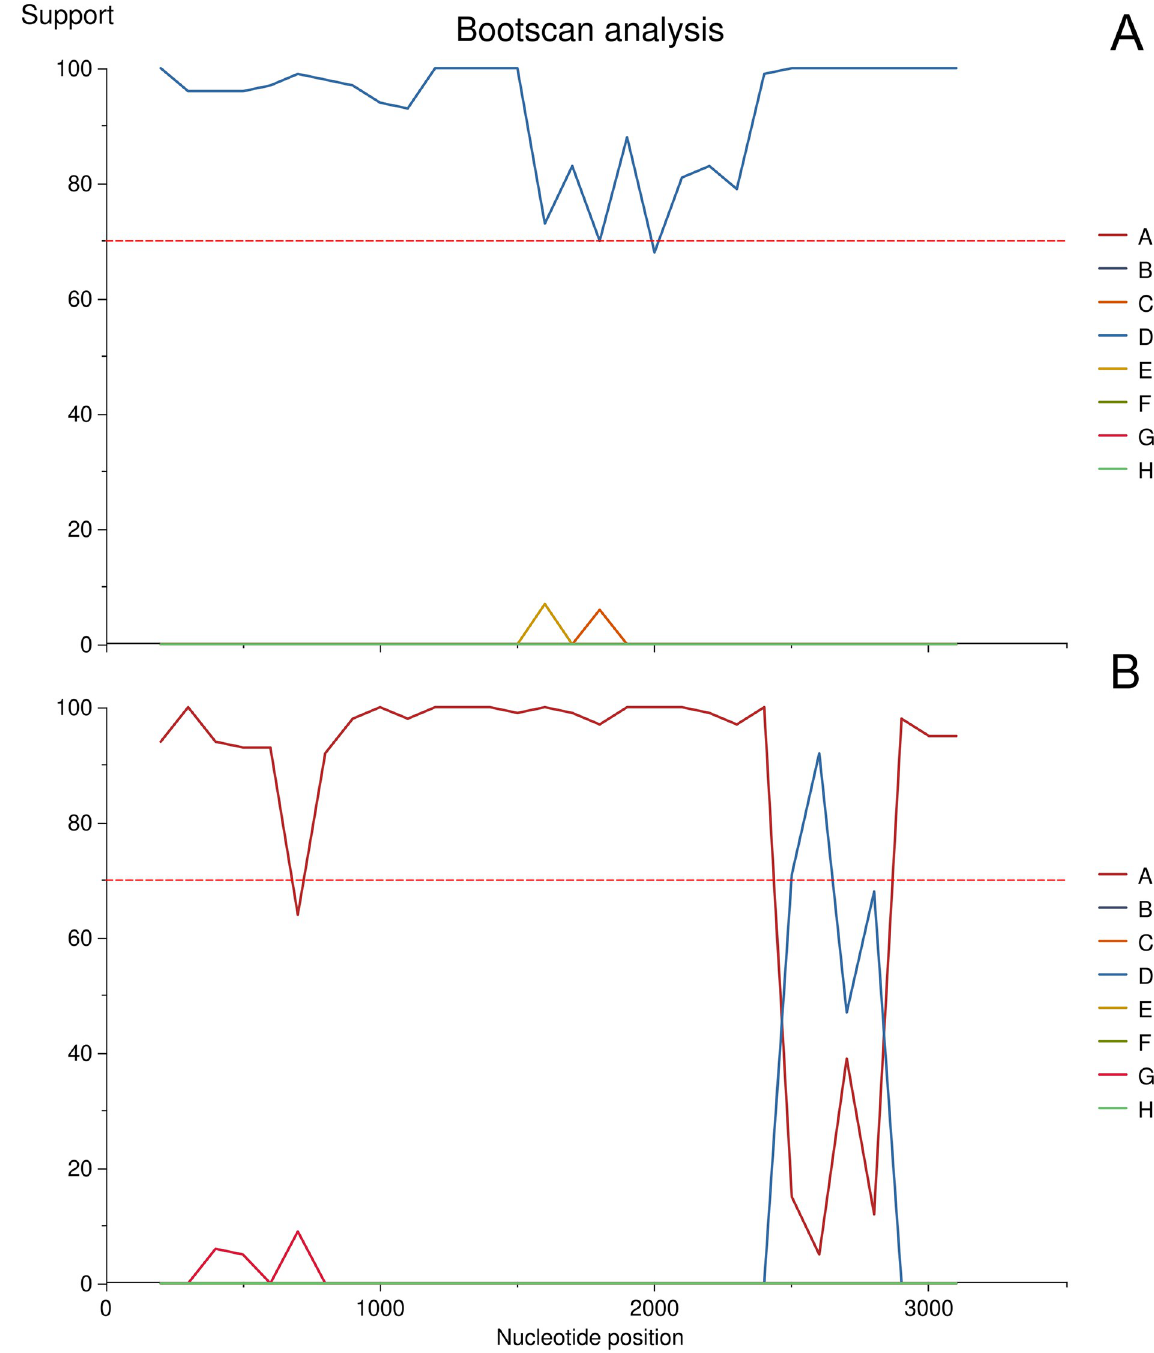
Fig 7. (A) Example of an unequivocally identified HBV sample (SRR12535946) and (B) a recombinant sample (SRR12535947) as output by Genome Detective using Bootscan. Values on the y-axis show positions of x belonging to a given cluster.